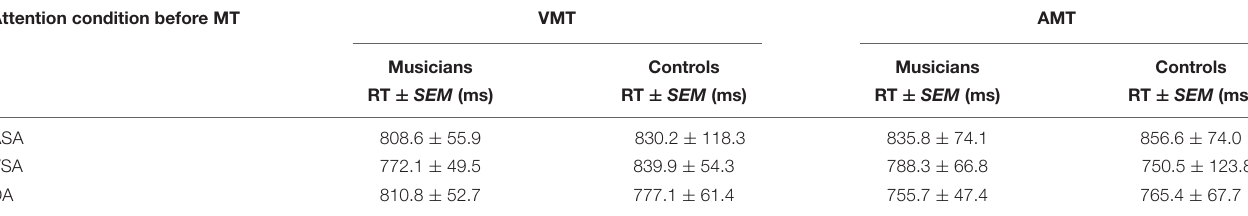
TABLE 3 | Reaction times for correct responses of the retrieval memory tasks after each attention condition. Attention condition before MT VMT AMT Musicians Controls